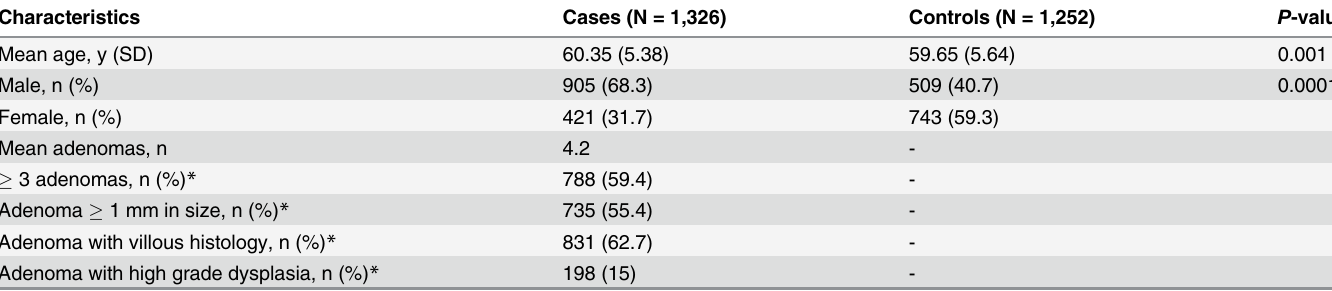
Table 1. Summary of the demographic and clinical characteristics of individuals included in the